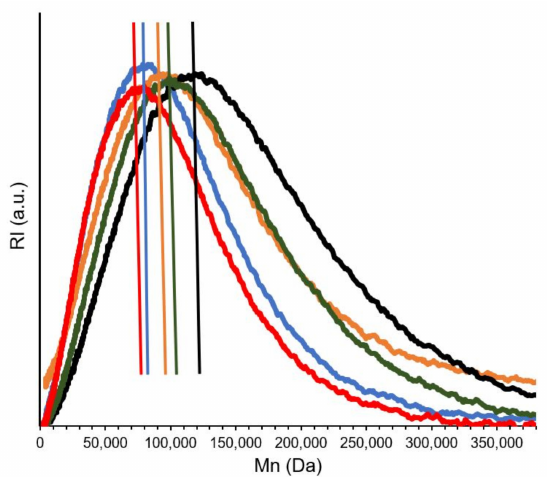
Figure 9. Number average molar mass distributions for the unirradiated sample (black) and samples irradiated at doses of 5 kGy (green), 10 kGy (orange), 15 kGy (blue), and 20 kGy (red). The lines rep- resent the number average molar mass M n value (center) of each trace at the peak of the